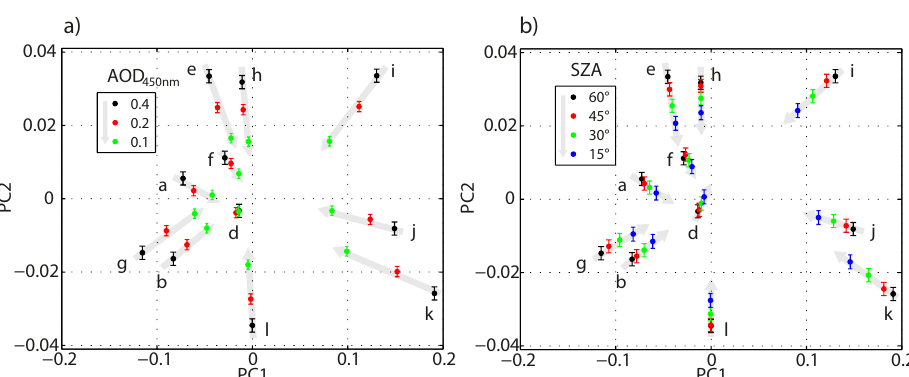
Fig. 7. (a) Effect of AOD on the PC representation of all aerosol types. The information content can be visualized as the area occupied by all points (of equal AOD) and decreases with decreasing AOD. (b) Effect of SZA on the PC representation of all aerosol types. The information content decreases with decreasing